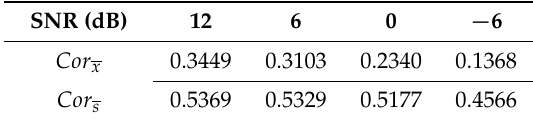
Table 4. Cor for BW with different signal noise ratio (SNR)